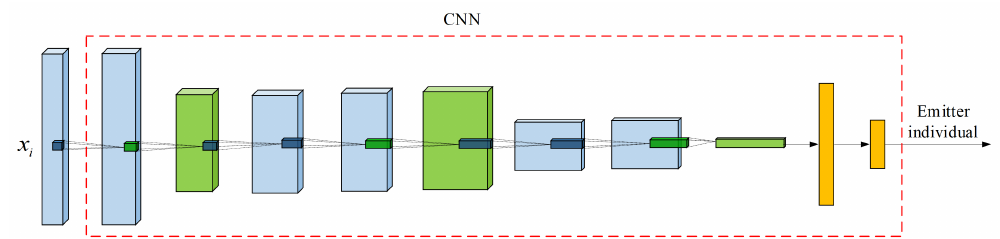
Figure 4. The MGRALN without auxiliary branches.